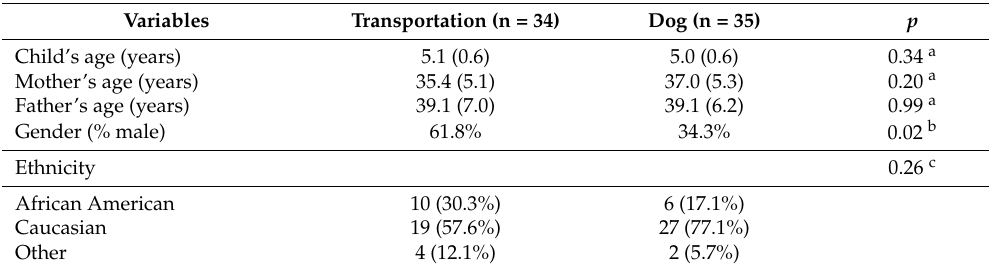
Figure 1. CONSORT flowchart of study enrollment. Table 1. Descriptive statistics (M (SD) or %) showing demographic characteristics of the randomized groups.